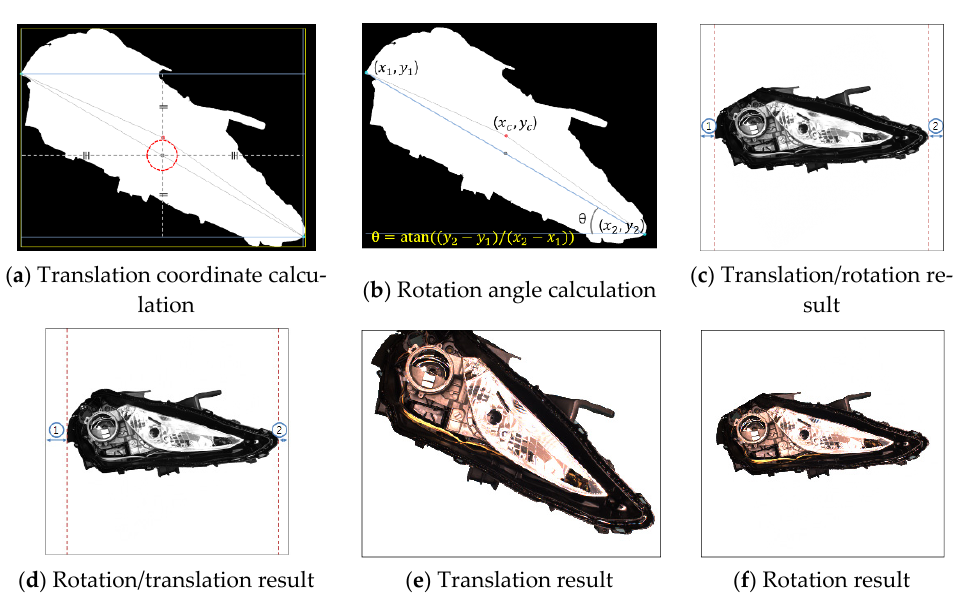
Figure 8. Image translation and rotation.